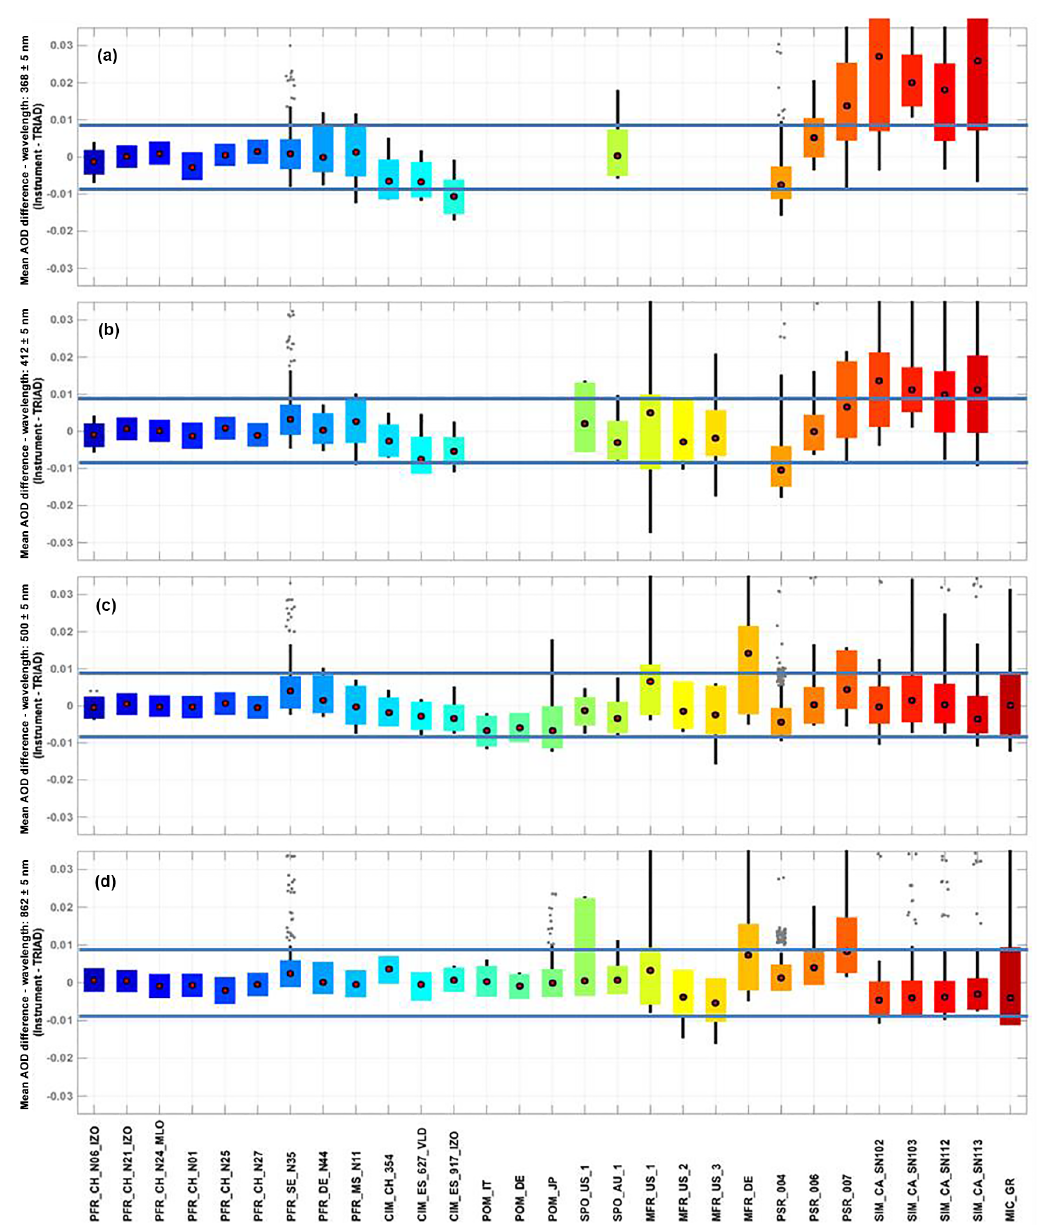
Figure 3. AOD comparison results at 368 ± 3nm (a) , 412 ± 3nm (b) , 500 ± 3nm (c) and 865 ± 5nm (d) . The black dots represent the median of the difference of each instrument from the mean of the triad at each wavelength over the five FRC-IV selected days. The boxes represent the 10th and 90th percentiles, while the black lines represent the minimum and maximum values of the distribution excluding the outliers. Outliers (gray dots) represent values that are outside the 10th and 90th percentiles by 4 times the width of the distribution at a 10% level. Cimel AOD at 368 and 412nm has been interpolated using the Cimel AOD at 340, 380 and 440nm and the Ångström exponents derived from these three wavelengths. Box colors are only used to differentiate between instruments. Blue lines represent the ± 0.09